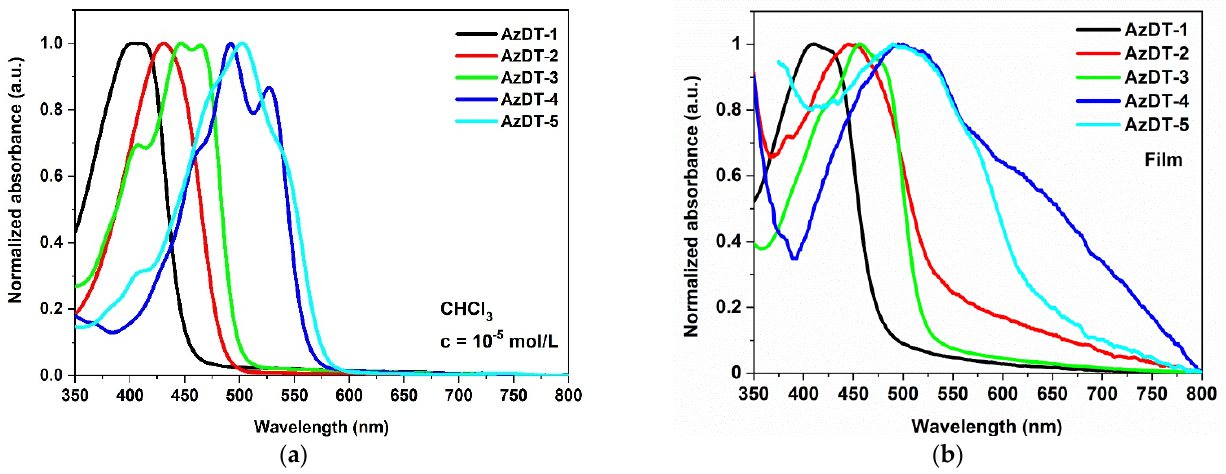
Figure 4. The UV-Visspectra of AzDTs in chloroform ( a ) and in ( b ) thin film. The imines in a solution absorbed the radiation with the maximum absorption band ( λ max ) located between 242 and 533 nm (2.22–5.12 eV; Table 3.). The absorption at higher energy ranges (3.82–5.12 eV) can be assigned to π → π * transitions [39,44]. The dominat- ing absorption bands were localized at the lower energies (2.33–3.09 eV) and were shift- ed towards longer wavelengths depending on the core structure: phenyl < biphenyl < triphenylamine < bitiophene < thieno[3,2-b]thiophene (Figure 4). There were no signifi- cant differences in the λ max position registered in various solvents ( ∆ λ max = 2–12 nm; Fig- ure S9inthe ESI). In the films, the maximum of the absorption bandwas very similar to λ max in the solutions (cf. Table 3 and Figure S9 in the ESI); however, the film of AzDT-3 (with TPA core) prepared from a chloroform solution showed a 10 nm red shift of the λ max compared to the solution. The broad absorption spectrum is presented in Figure S9 in the ESI, and was recorded for imines with a bitiophene (AzDT-5) and a thieno[3,2- b]thiophene (AzDT-4) core with the λ max located at the highest absorption coefficient in the solutions. The presented molecules showed weak light emission in the solutions, and the PL quantum yield ( ϕ ) was below 2.5% and was none-emissive in the solid state. Such be- havior was also reported in our previous publications for unsymmetrical and symmet- ricalthiophene-based azomethines [43,44]. The excited states are deactivated in a non- radiative way, which may be related to the presence of a heavy atom (sulfur) and inter- nal conversion. In the solutions, the PL spectra were shifted towards the longer wave- lengths depending on the core structure, as in the case of the absorption spectra (Figure 5).